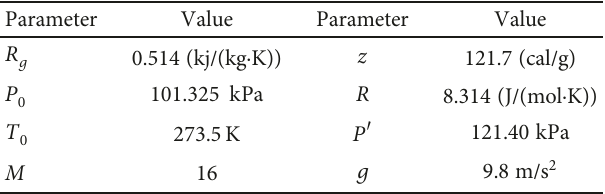
Table 1: Nomenclature of the parameters appearing in the formula. Parameter Value Parameter Value R